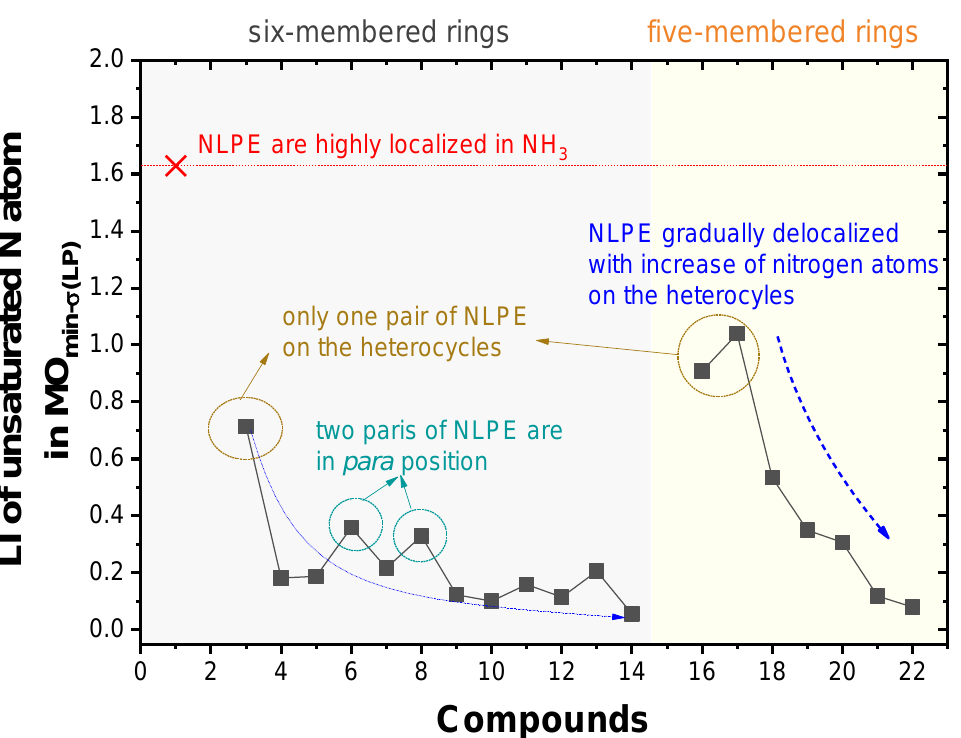
Figure 1. Localization index (LI) of unsaturated nitrogen atom in each lowest σ (LP) orbital for the 22 studied compounds.